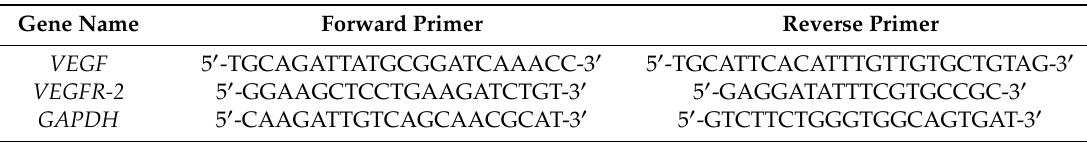
Table 1. Primer sequences used for semi-quantitative reverse-transcription polymerase chain reaction